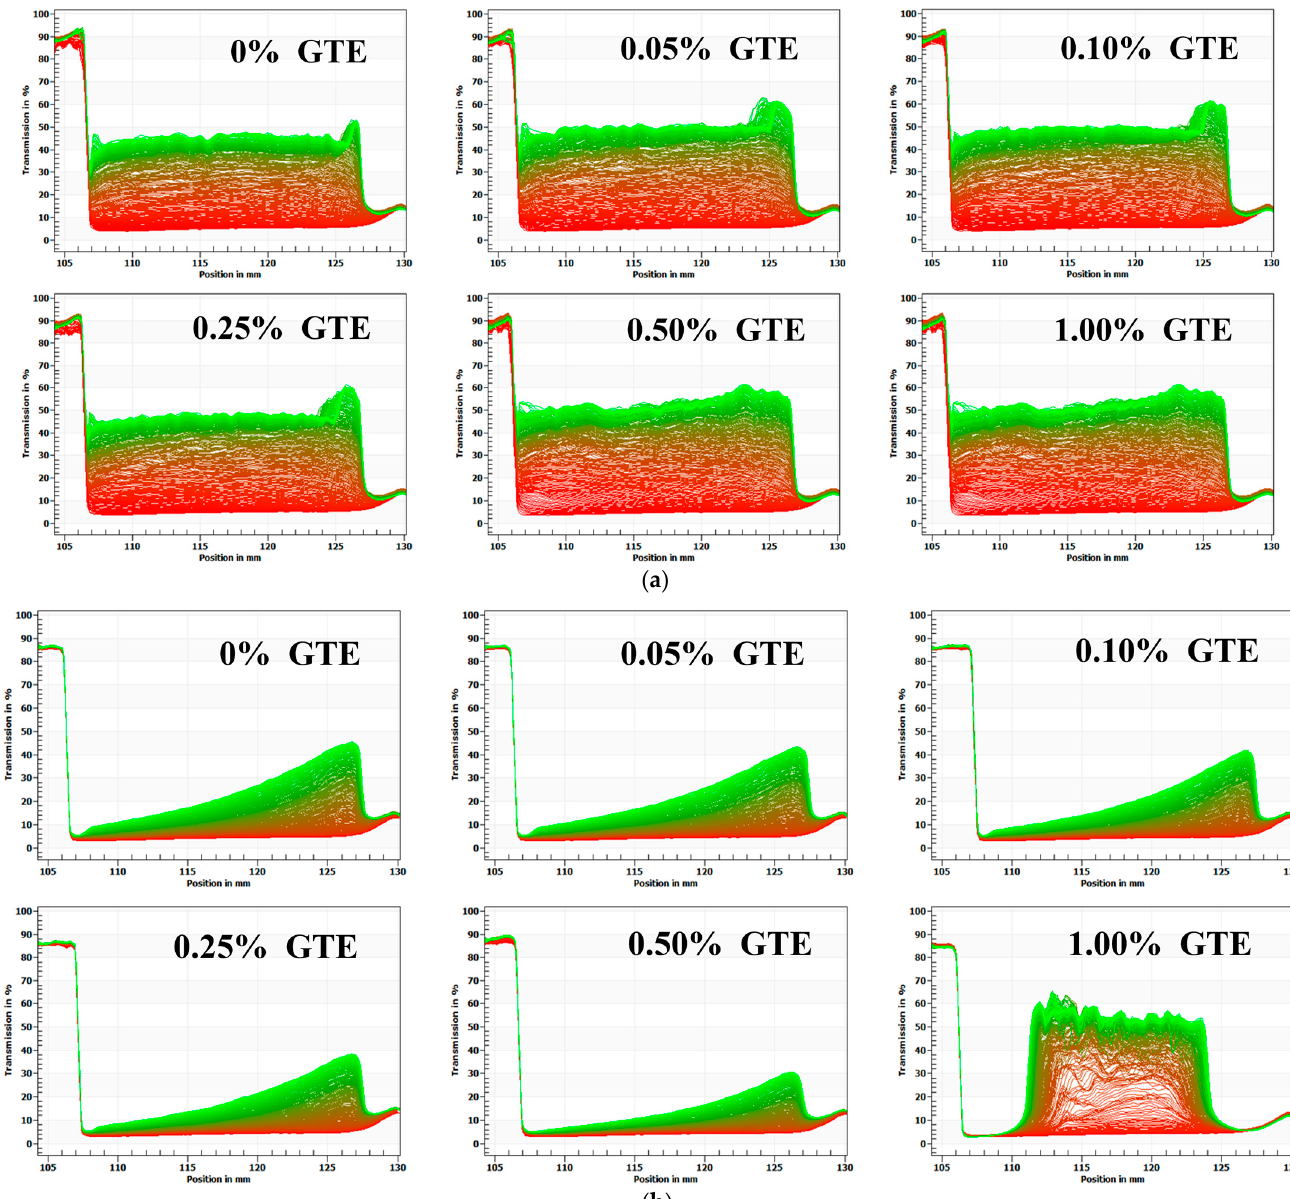
Figure 2. The physical stability of oat milk tea model systems: ( a ) 1.5% fat oat milk tea model system and ( b ) 3.0% fat oat milk tea model system .